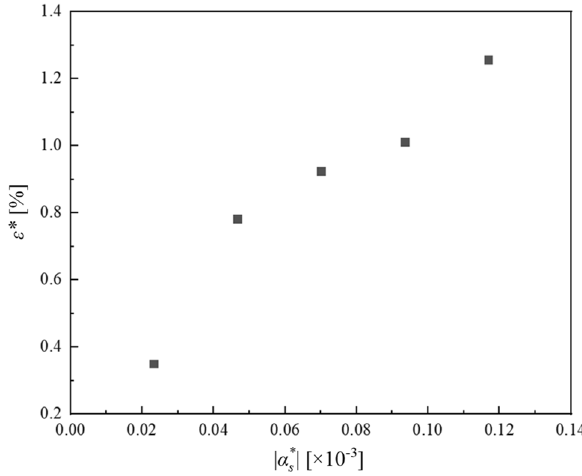
Figure 11. Relationship between α ∗ s and ε ∗ .